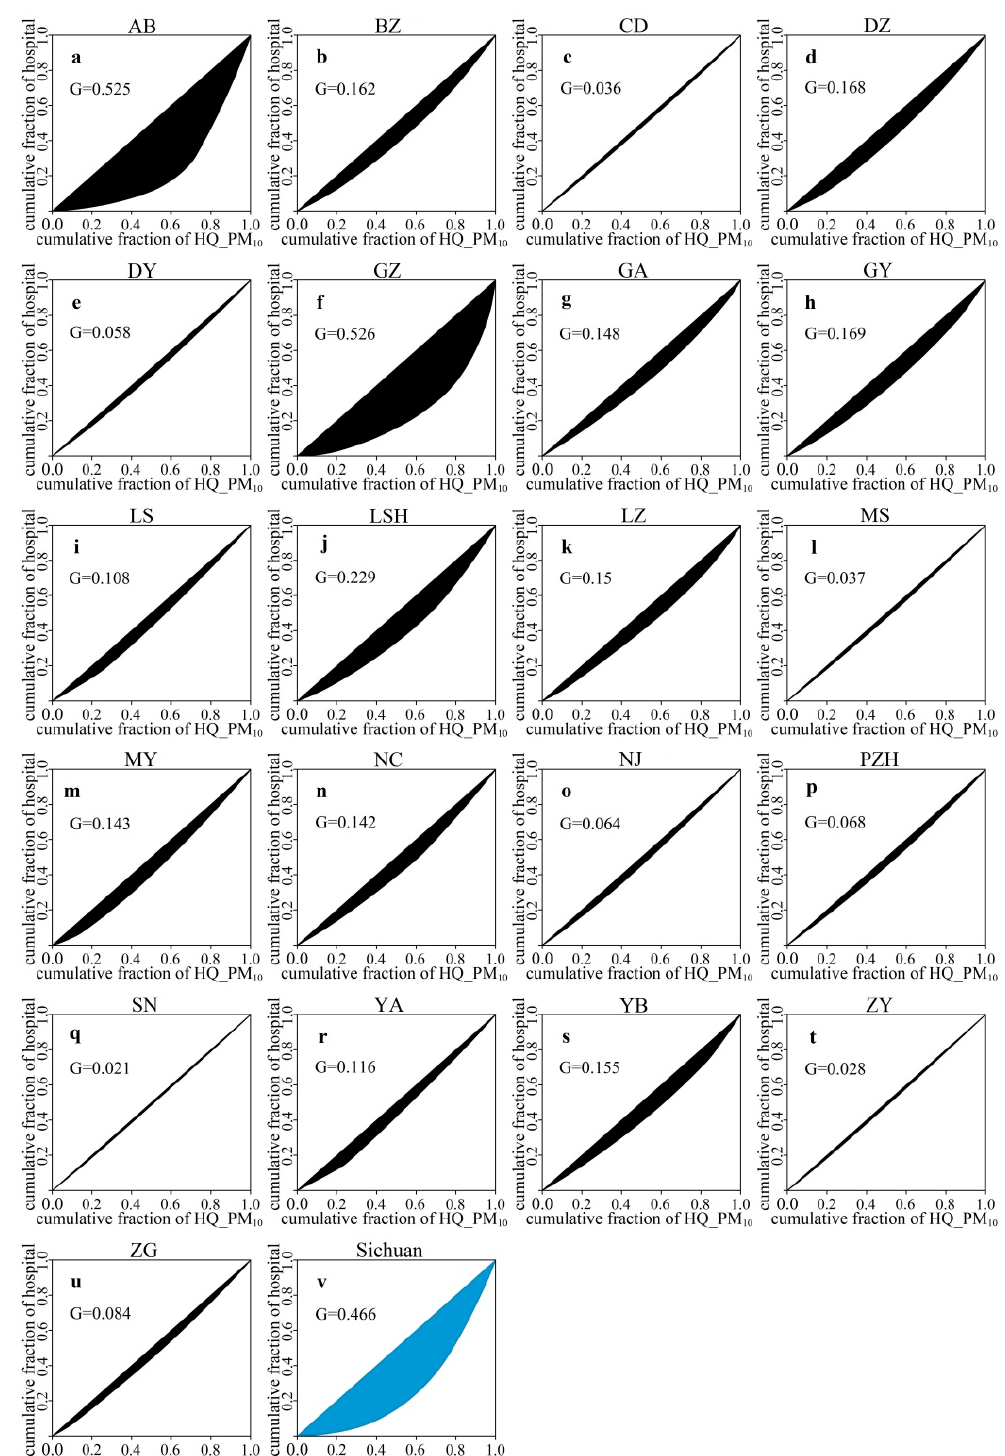
Figure 7. Spatial inequality analysis between the infant hazard quotient caused by PM 10 (HQ_PM 10 ) and hospital density: ( a ) Aba, ( b ) Bazhong, ( c ) Chengdu, ( d ) Dazhou, ( e ) Deyang, ( f ) Ganzi, ( g ) Guangan, ( h ) Guangyuan, ( i ) Leshan, ( j ) Liangshan, ( k ) Luzhou, ( l ) Meishan, ( m ) Mianyang, ( n ) Nanchong, ( o ) Neijiang, ( p ) Panzhihua, ( q ) Suining, ( r ) Yaan, ( s ) Yibin, ( t ) Ziyang, ( u ) Zigong, and ( v ) Sichuan.